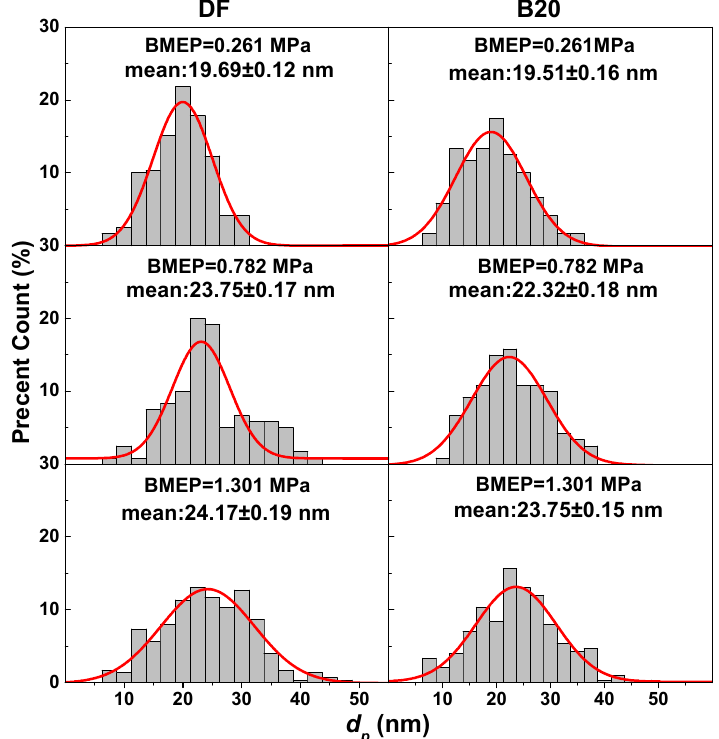
Figure 3. Distributions of primary particle size (d p ) for both DF and B20 soot in the various test modes .